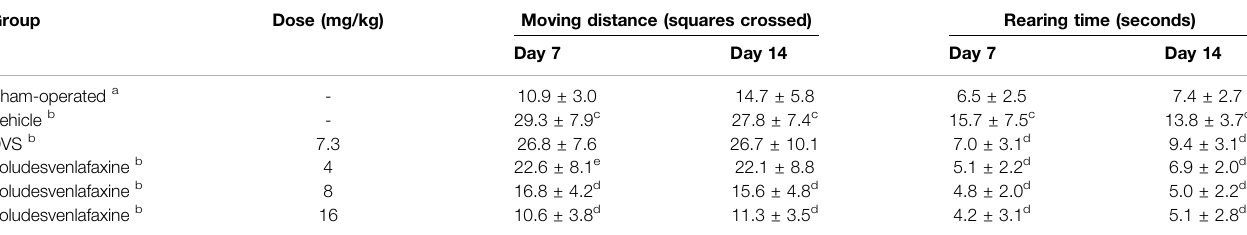
TABLE 3 | Effects of toludesvenlafaxine on the Locomotor activity in olfactory bulbectomized rats. Group Dose (mg/kg) Moving distance (squares crossed)